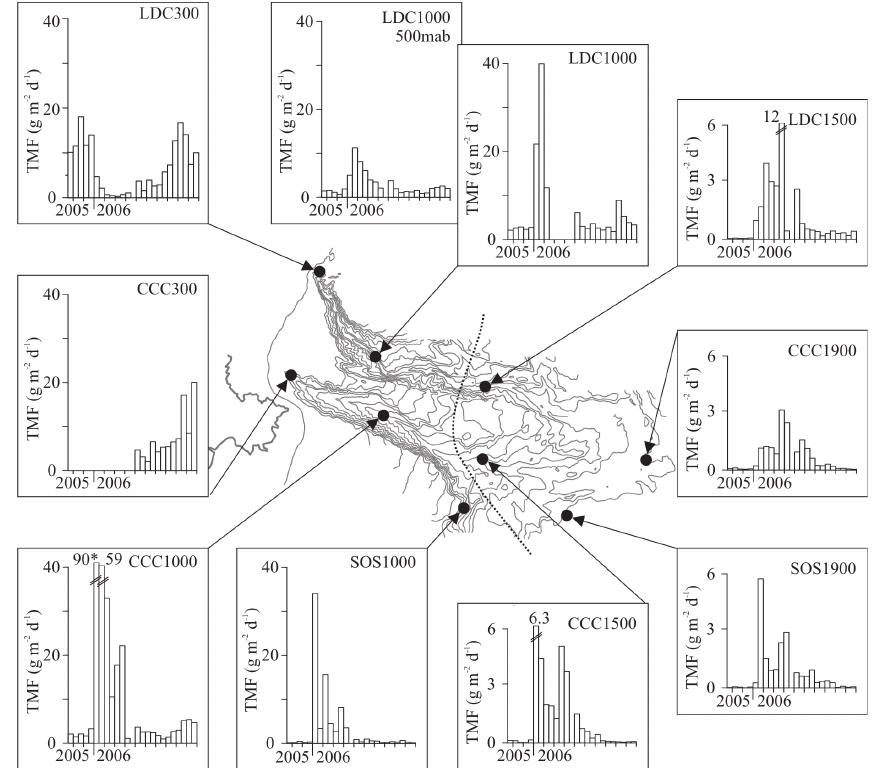
Fig. 4. Time series of total mass fluxes (gm − 2 d − 1 ) along transects studied: Lacaze-Duthiers Canyon (LDC), Cap de Creus Canyon (CCC) and Southern Open Slope (SOS), at different water depth stations. Contour every 100m (note that dotted line separate stations with different scale of the TMF axis). ∗